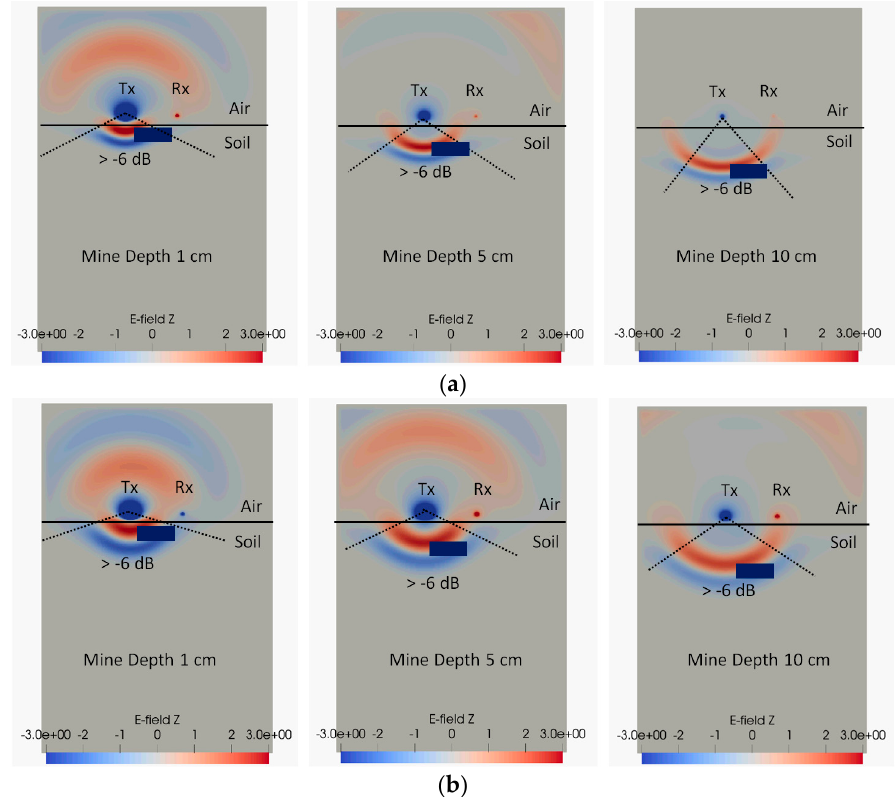
Figure 9. Radiating signal at different depths in lossy soil: ( a ) With a relative permittivity of 20; ( b ) with a relative permittivity of 8.